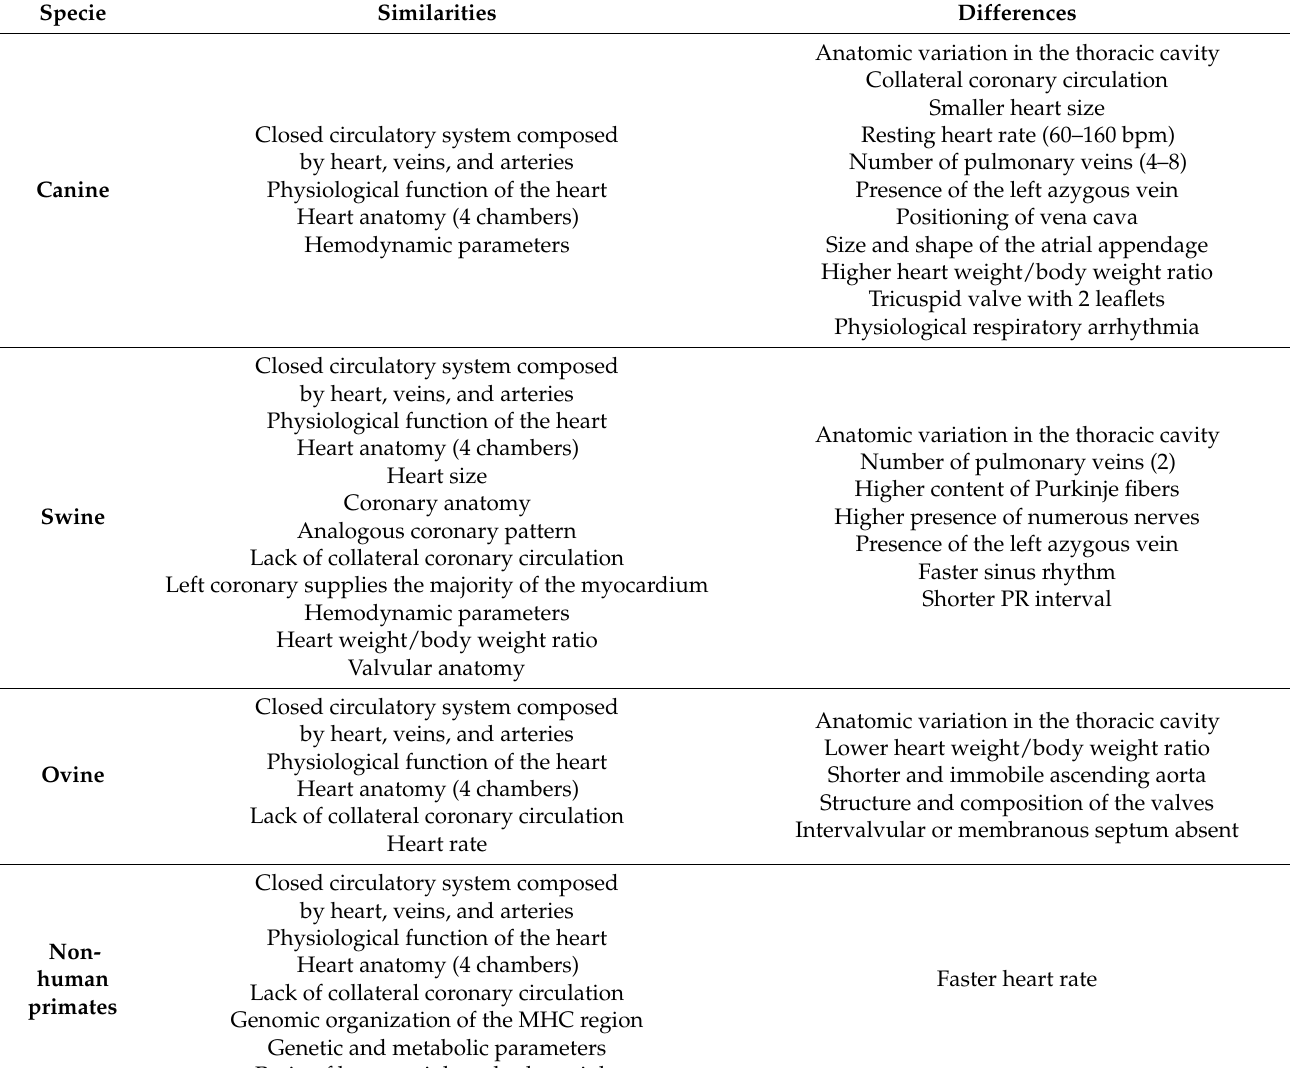
Table 1. Cardiac similarities and differences of large animals compared to